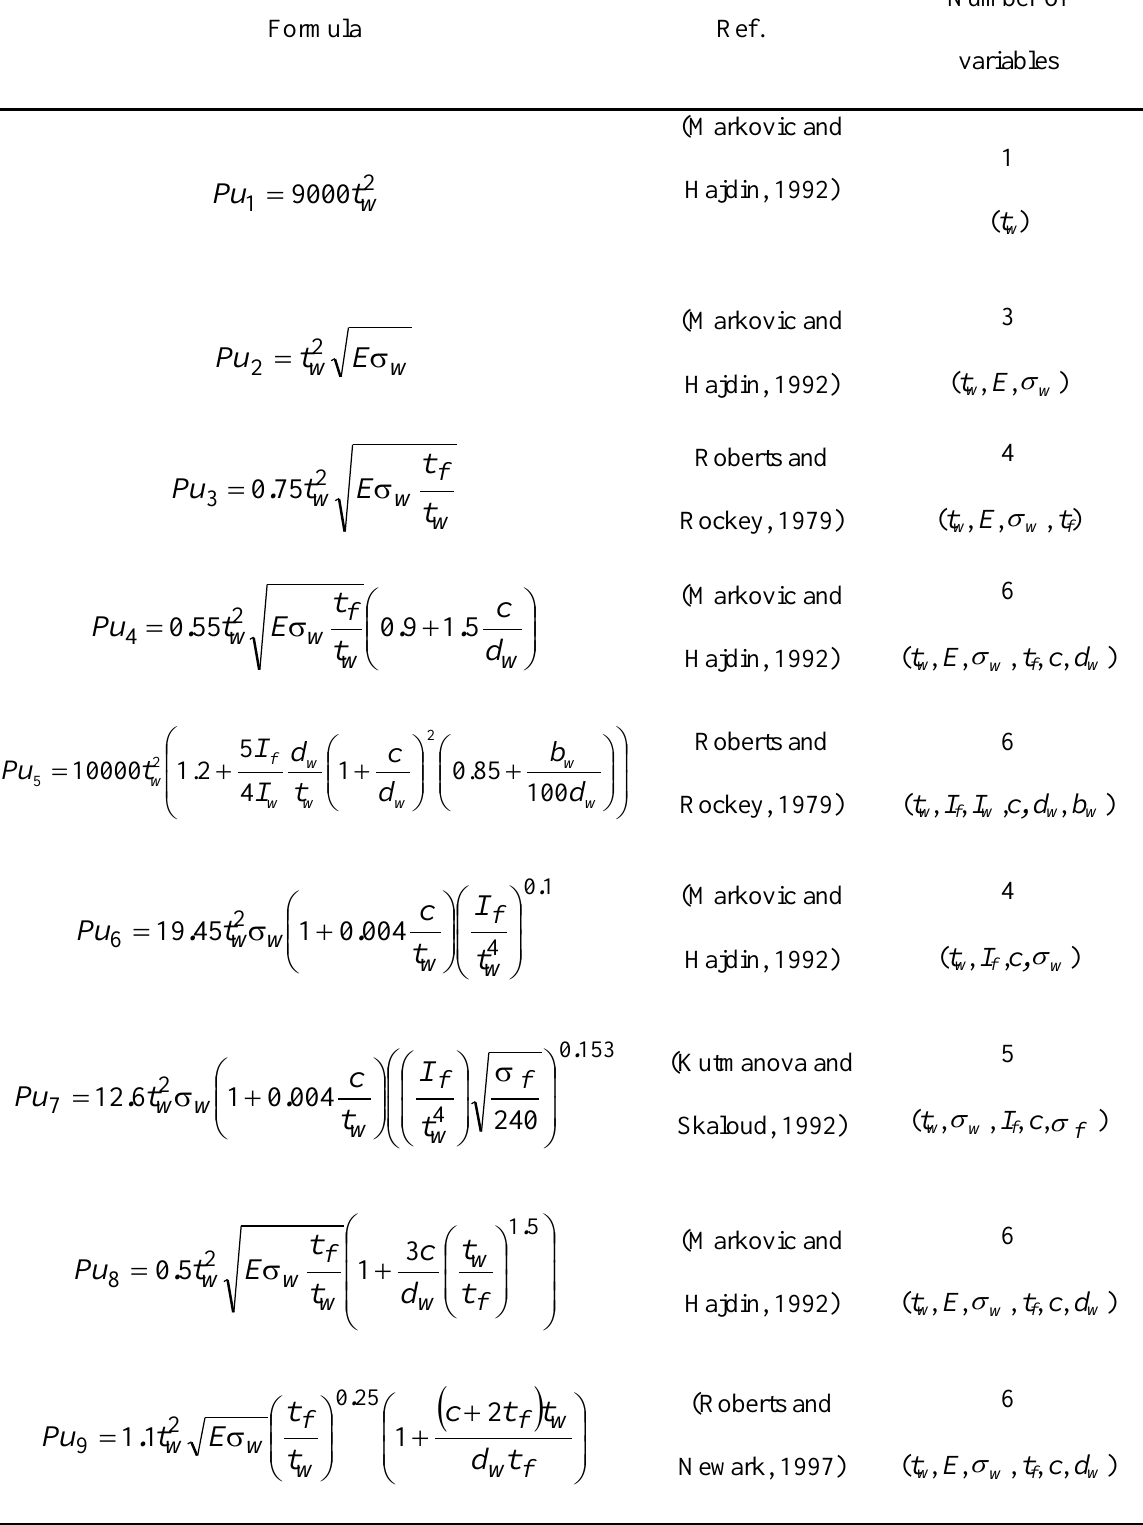
Table 1. Models for patch load resistance of plate girders. Formula